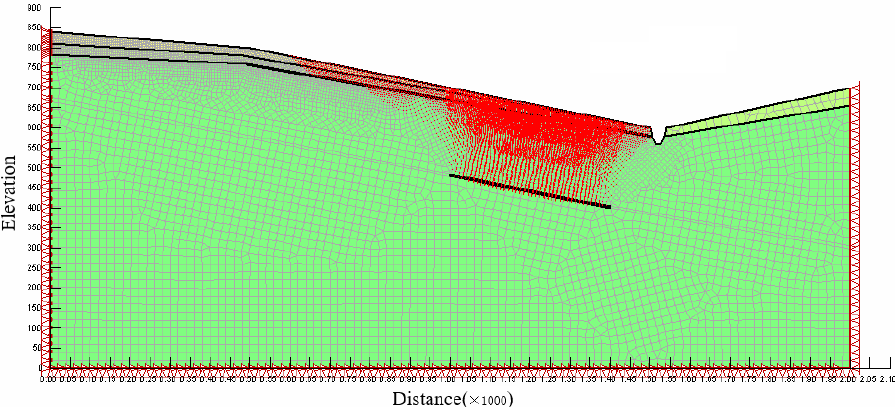
Figure 10. Displacement vector of slope before sliding.